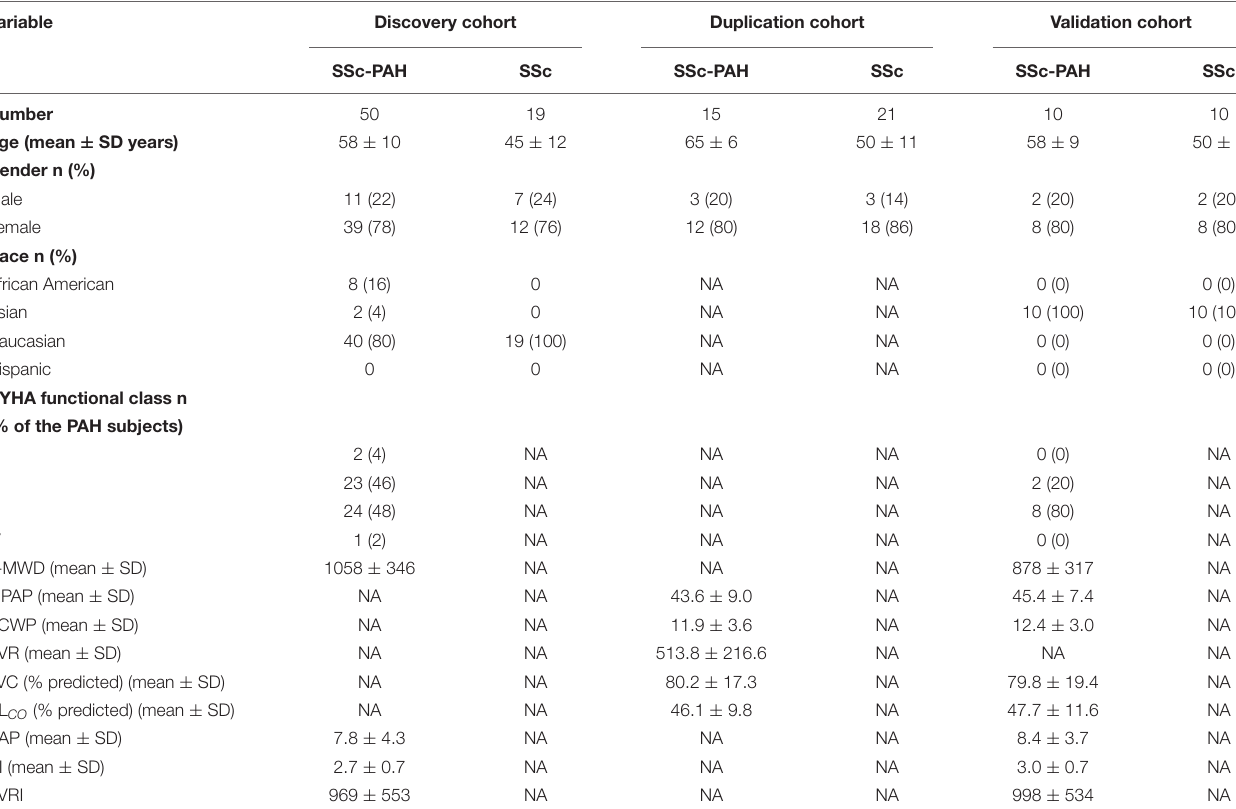
TABLE 2 | Subject characteristics. Variable Discovery cohort